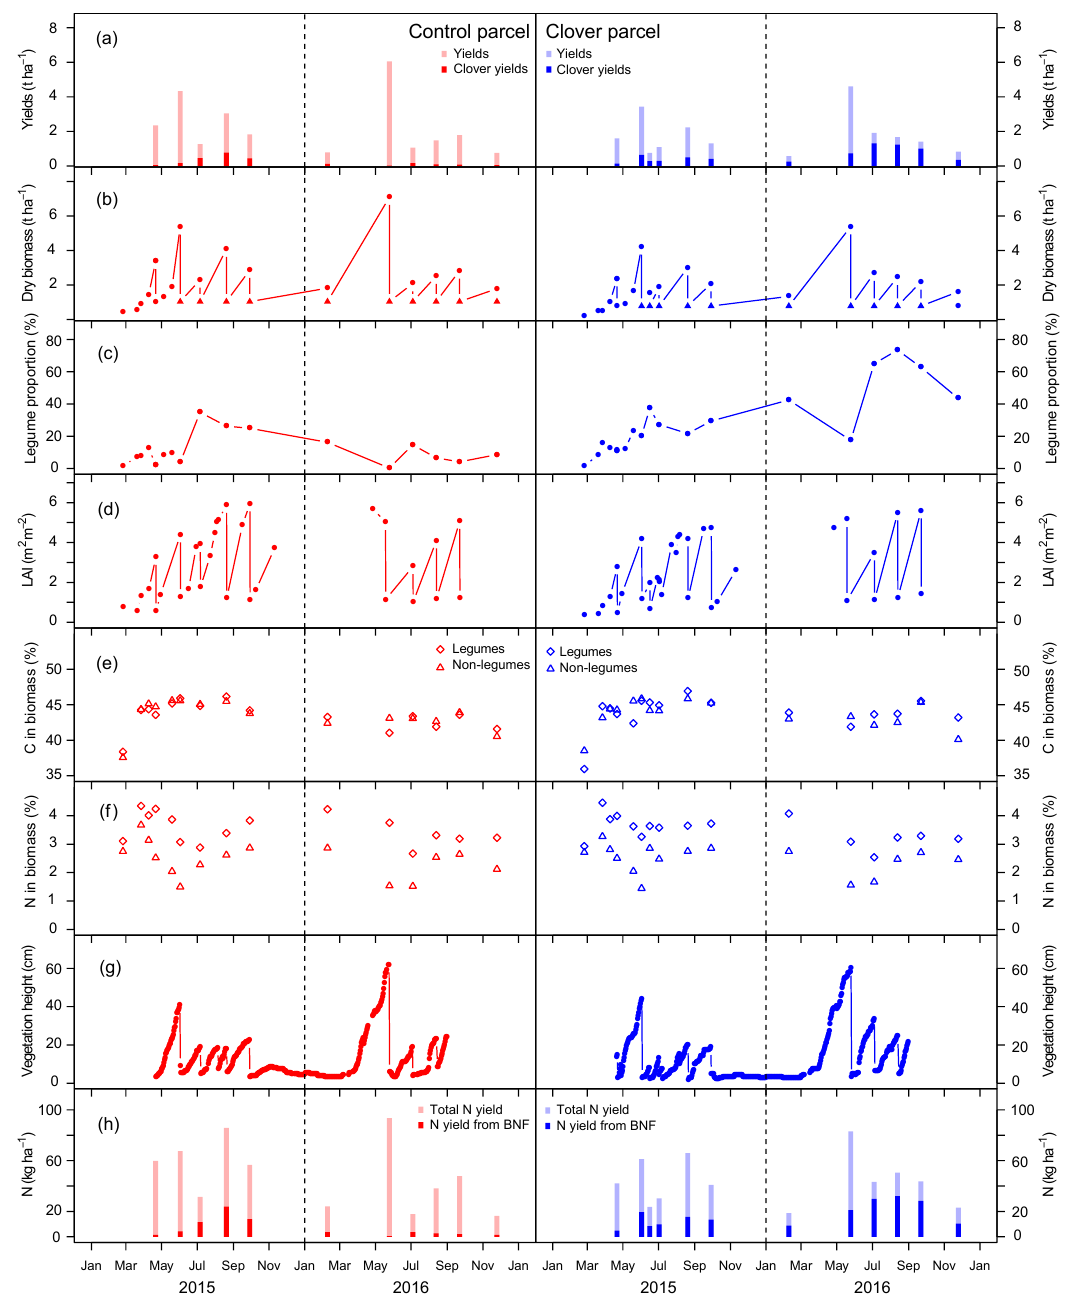
Figure 5. (a) Yields and intake by grazing at the control (left, red) and clover parcel (right, blue); (b) total aboveground biomass. Circles represent the total biomass (legumes and non-legumes), and filled triangles display the remaining biomass after harvest (stubble), which was measured once (sampling date 21 April 2015) and assumed to be approximately similar during subsequent harvests. (c) Clover proportion in dry biomass, (d) leaf area index (LAI), (e) C content, and (f) N content in biomass. Diamonds represent the legumes and triangles non- legumes. (g) Vegetation heights derived from webcam images; (h) amounts of total N removal at harvest (semi-transparent), including total amount of BFN in the removed biomass